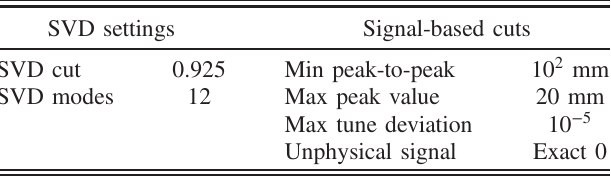
TABLE I. Default SVD settings and signal cuts used in